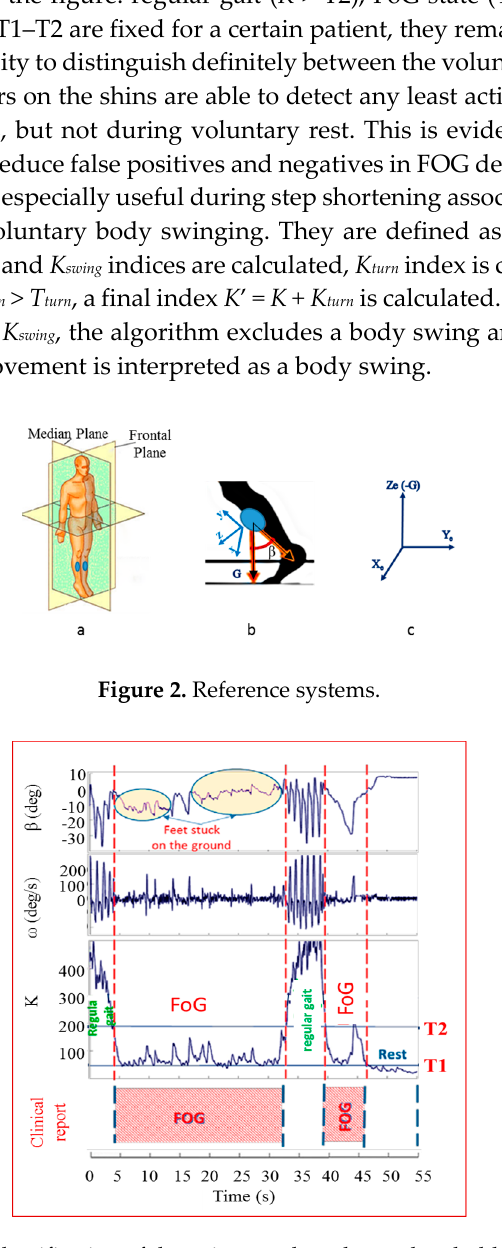
Figure 3. Classification of the gait states based on a threshold